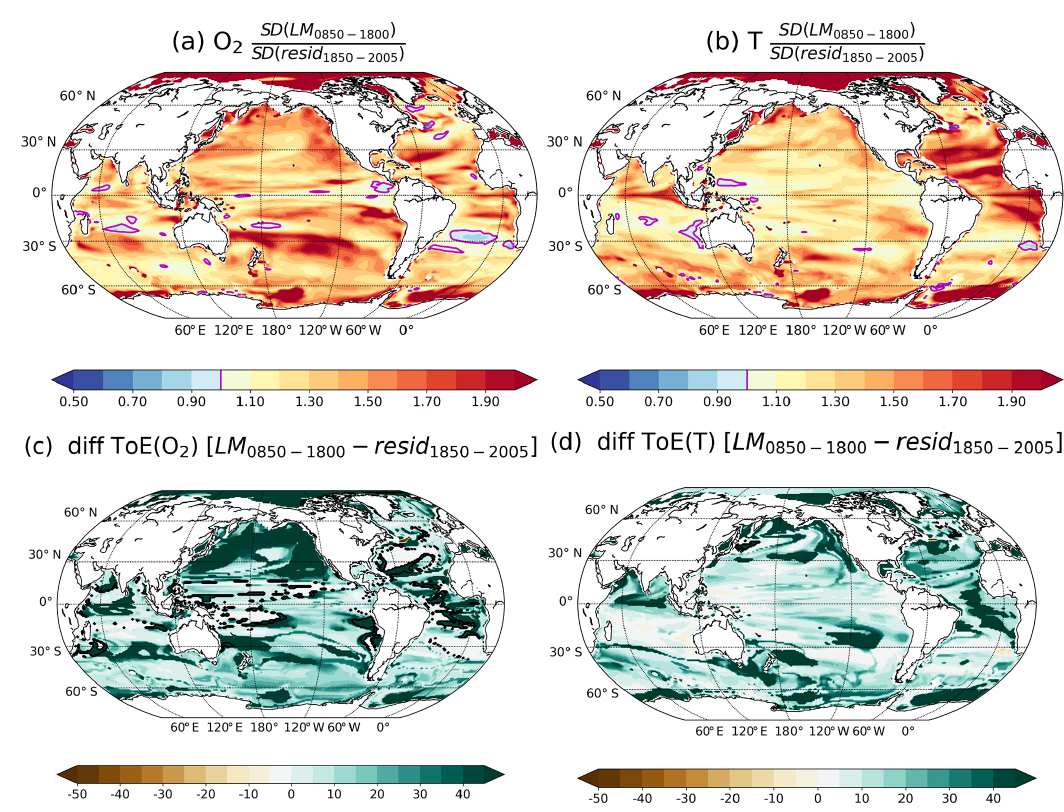
Figure 6. Ratio of the SDs of the forced simulation computed over the period 850–1800CE and of the residual variability computed over the period 1850–2005CE using a cut-off period of 40 years for (a) O 2 and (b) T . Difference of ToE using the SD of the forced simulation minus the ToE using the residual variability for (c) O 2 and (d) T . The magenta contours highlight the ratio equal to 1, i.e. where SDs are equal. SDs are computed from annually and vertically averaged values between 200 and